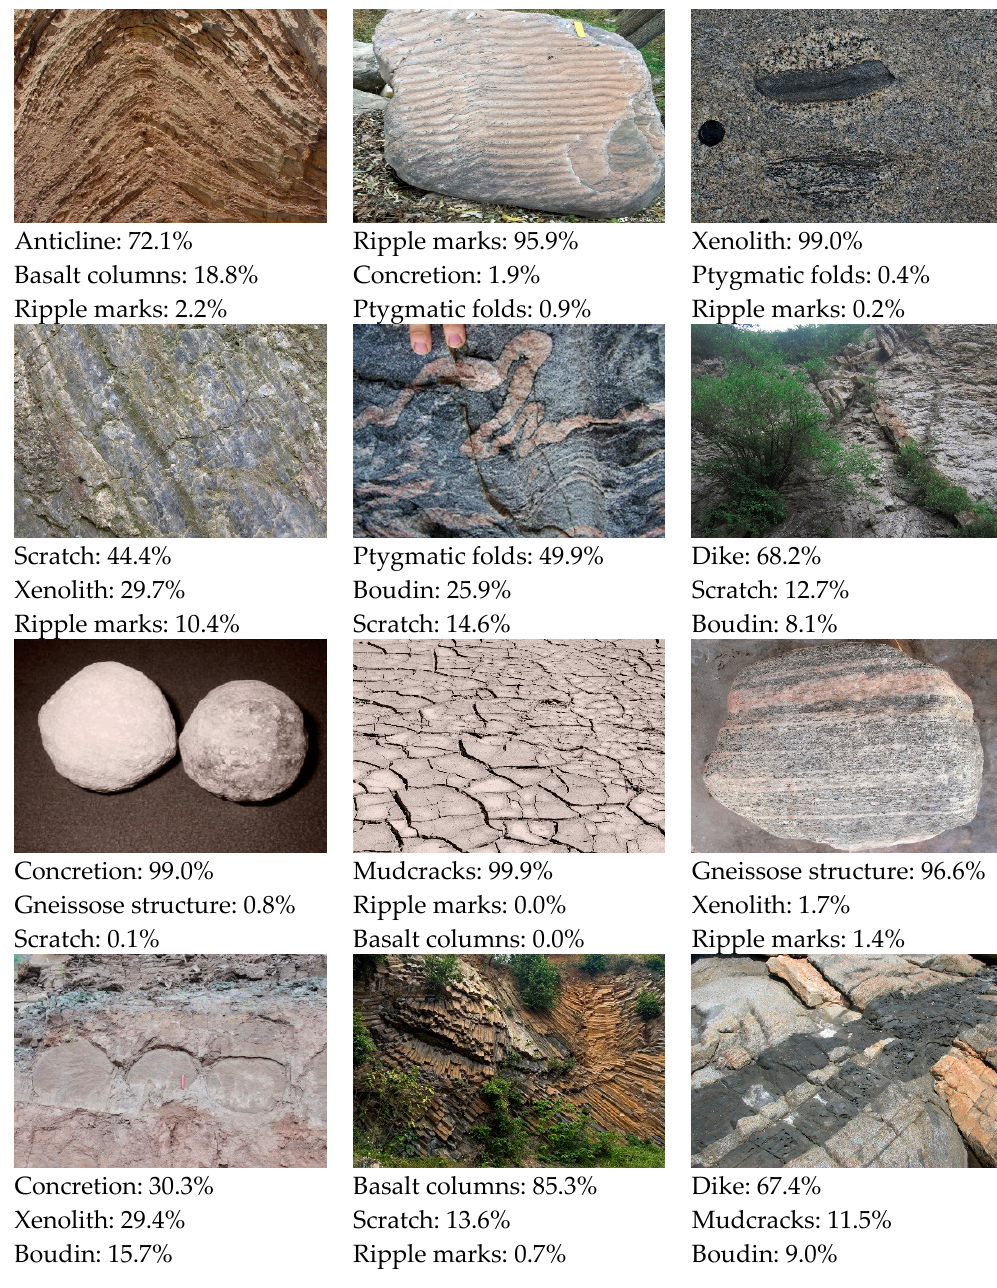
Figure 7. Identification of geological structures images results.